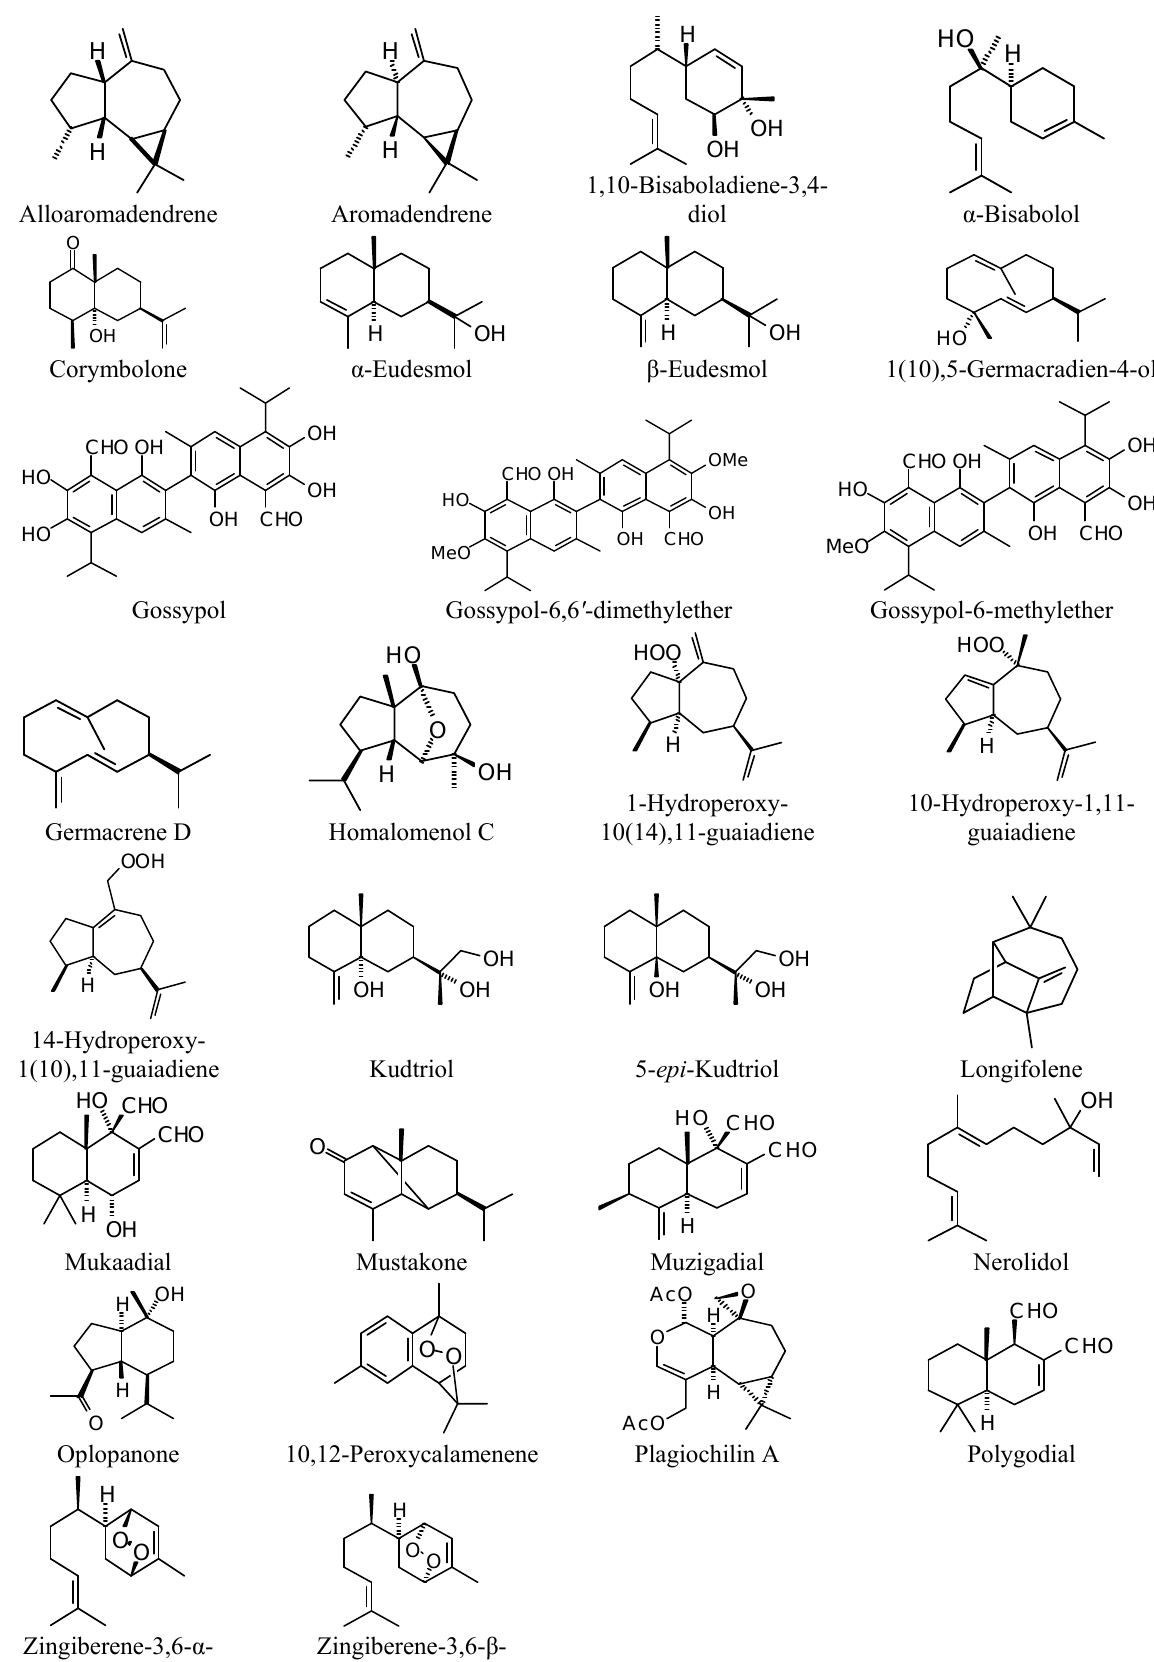
Figure 5. Miscellaneous sesquiterpenoids examined in this